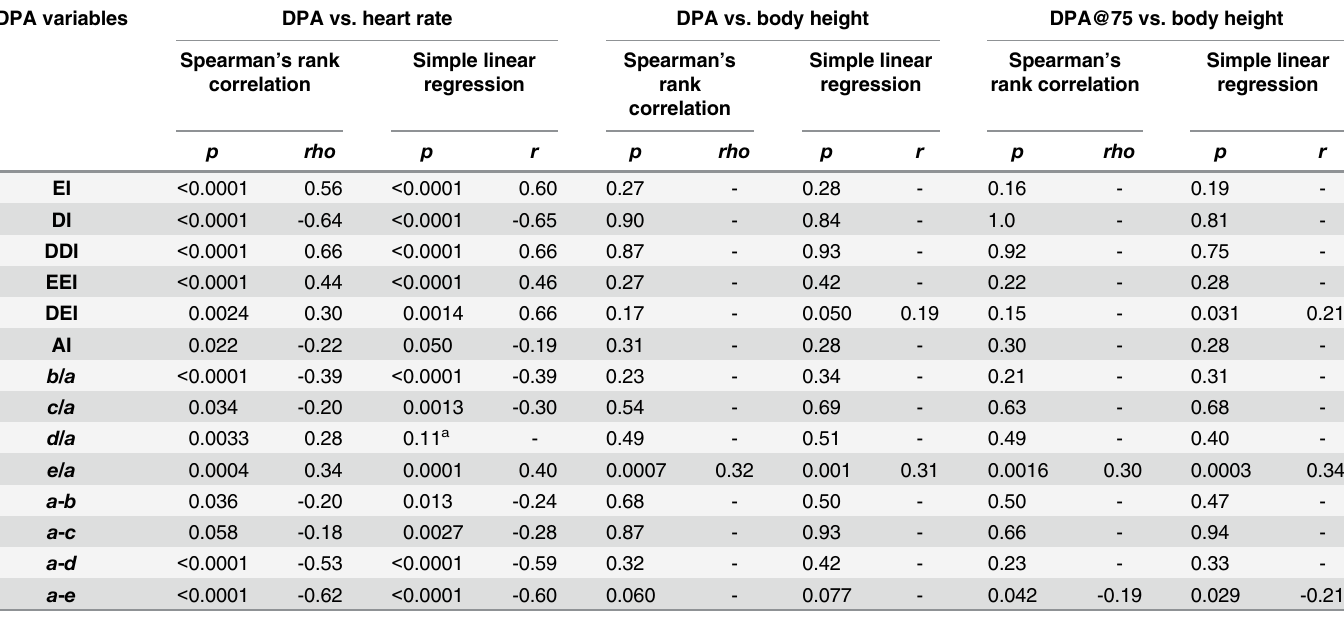
Table 3. Correlation between DPA variables and heart rate and body height, respectively, in 112 individuals. DPA@75 denotes adjustment of the var- iable to a heart rate of 75